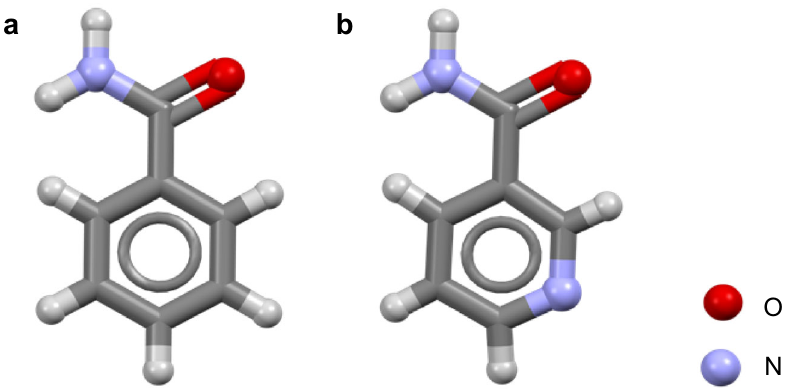
Fig. 1 Molecular structures of benzamide (BZM) and nicotinamide (NCM). Molecular structures of ( a ) benzamide and ( b )